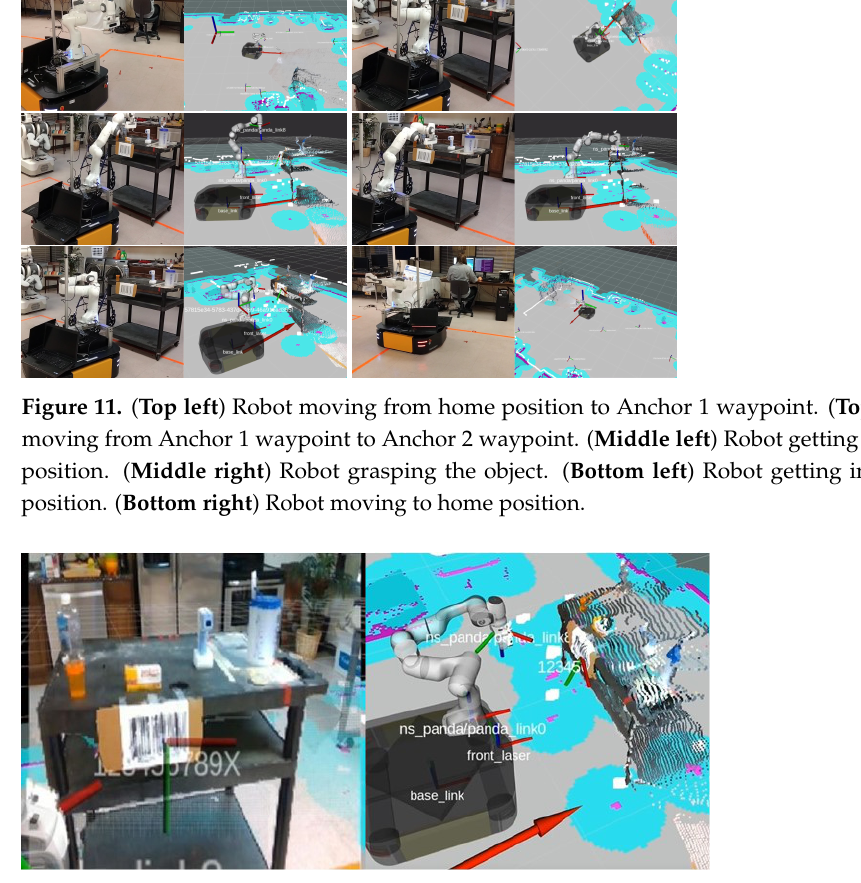
Figure 12. Barcode detected and highlighted at the detected location in the point cloud shown from camera view ( left ) and rviz view ( right ).